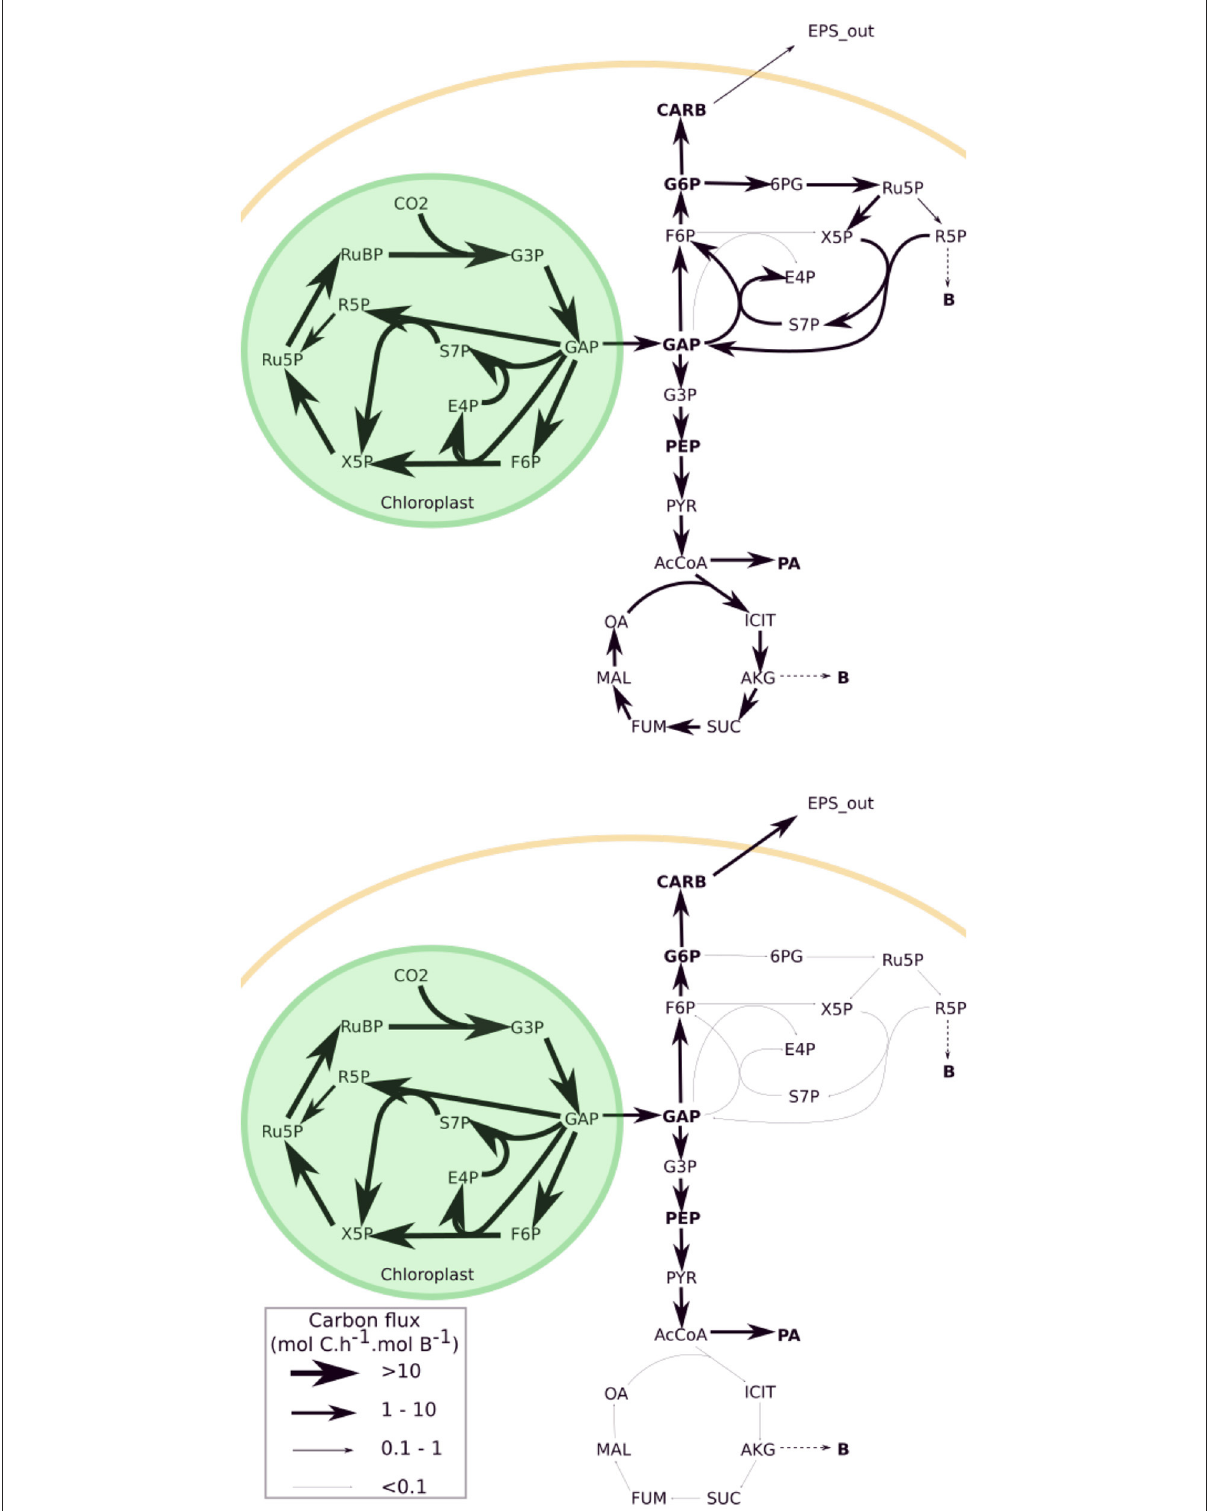
FIGURE5 Metabolic fluxes obtained with the ExCARB model at noon for nitrogen replete (top, t = 0.75 d) and starved (bottom, t = 3.75 d) conditions. The conversion between flux map is given is the legend box of the figure (the same conversion was used for both maps). Bold metabolites indicate metabolites A allowed to accumulate. The complete names of metabolites can be found in the list of